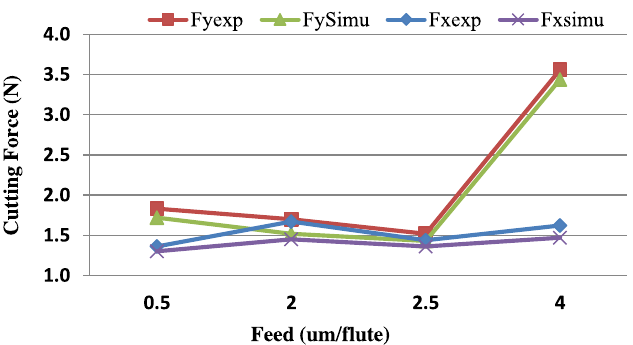
Fig. 10. Comparison of experimental and simulated cutting force at cutting speed 60,000 rpm, depth of cut 50 m m and feed 0.5, 2, 2.5, 4 m